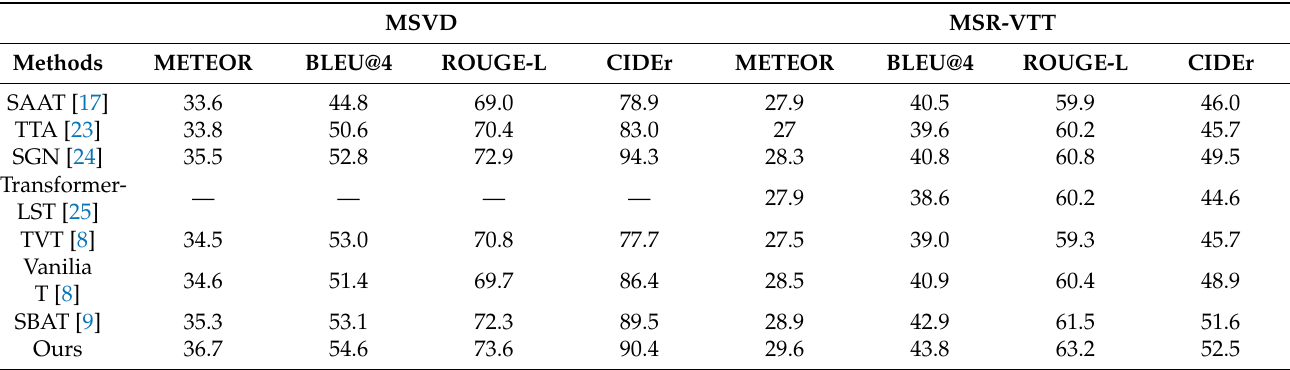
Table 1. Test results on MSVD, MSR-VTT test sets.